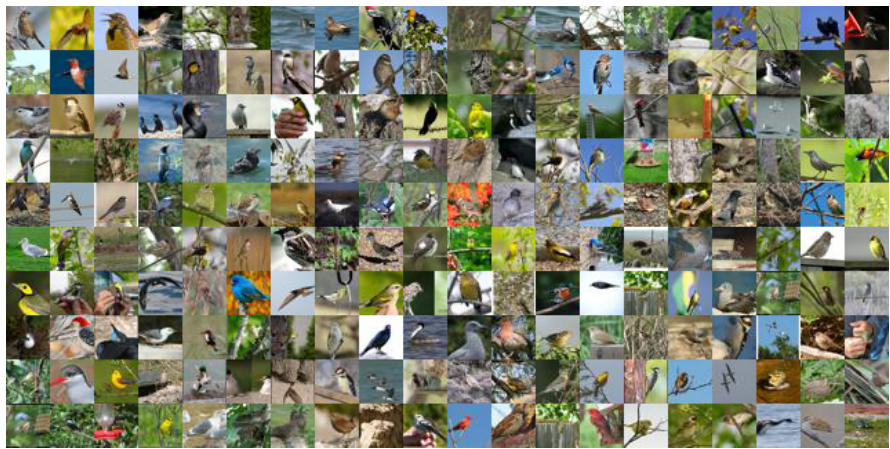
Figure 5. A sample image for each of the 200 classes of the CUB200-2011